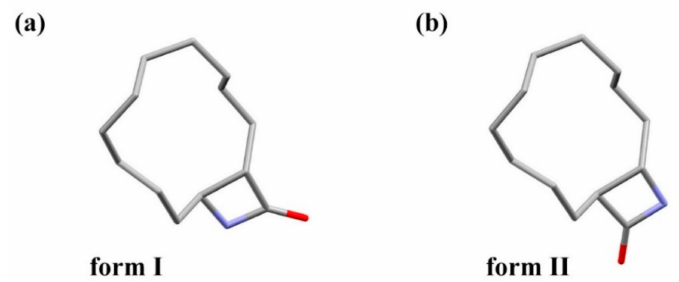
Figure 1. The molecular structures of β -lactam forms I and II. For easy identification, the hydrogen atom has been deleted, and the red color represents the oxygen